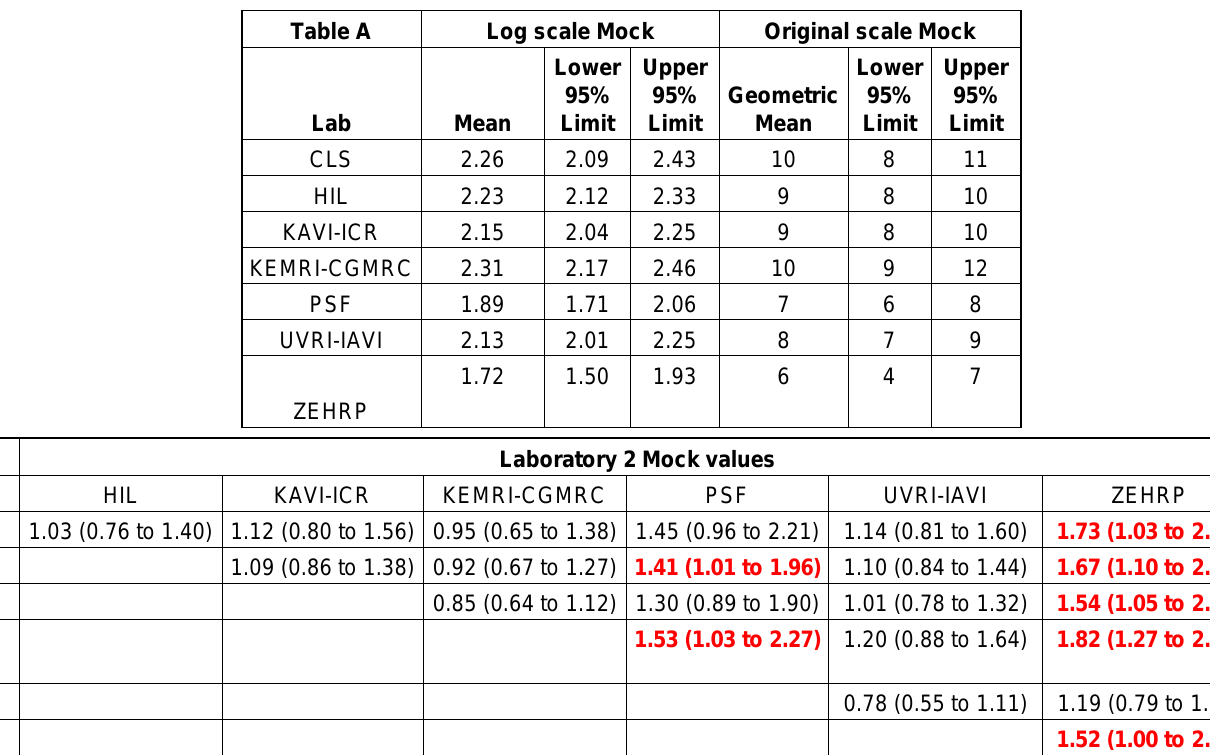
TABLE 1A & 1B-S1: Least squares mean mock counts and differences between laboratories. S1A Table: Mock. Least squares parameter estimates and 95% confidence intervals of mean spot counts (Bonferroni adjusted) from a repeated measures Poisson regression model of spot count on subject, site and month. S1B Table: Pairwise comparisons between sites, adjusted (Bonferroni) for multiple comparisons, from the same regression model as S1A Table above. Each cell shows the difference in least squares mean log count (Lab 1 - Lab 2) with 95% Confidence Intervals, exponentiated to the original scale (Overall p-values from regression model: Site = 0.0007, Month = 0.053).